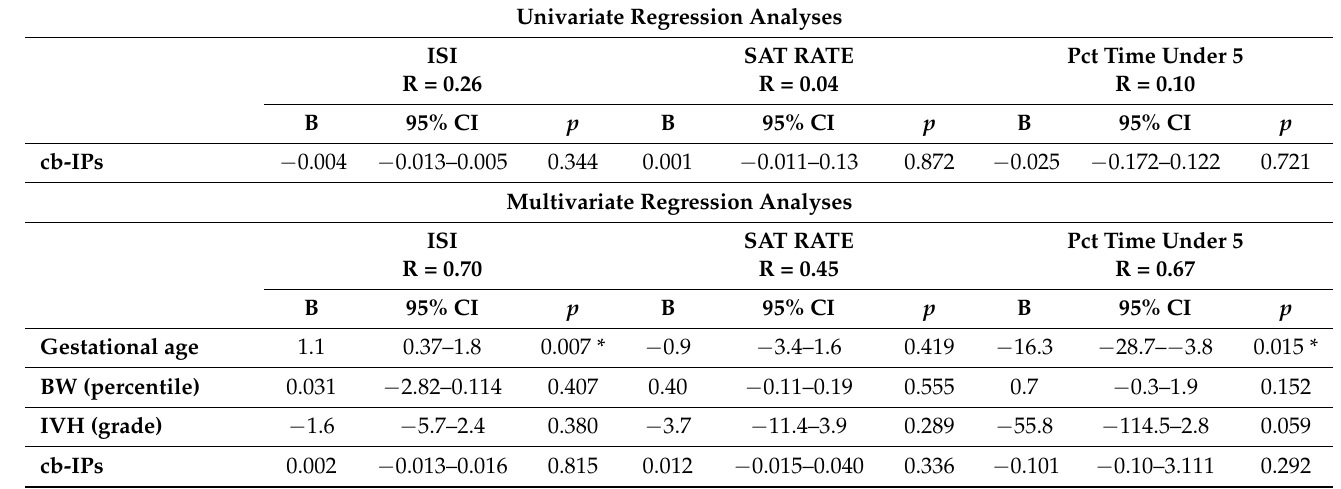
Table 2. Univariate and multivariate linear regression analysis between cb-IPs and early brain activity at day 1.